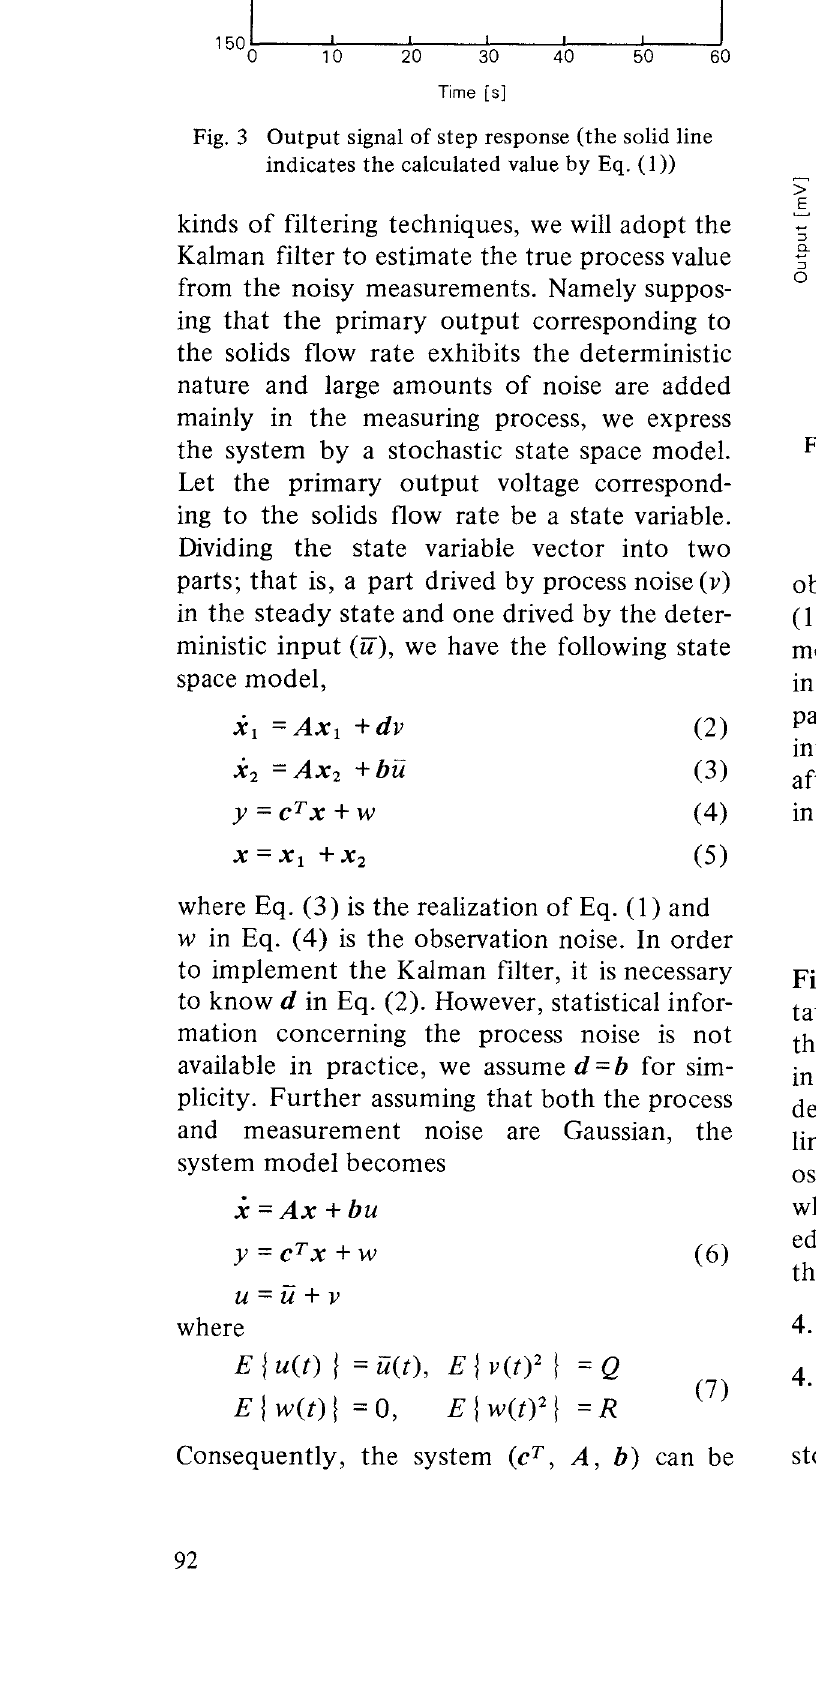
Fig. 3 Output signal of step response (the solid line indicates the calculated value by Eq. (1 )) 300